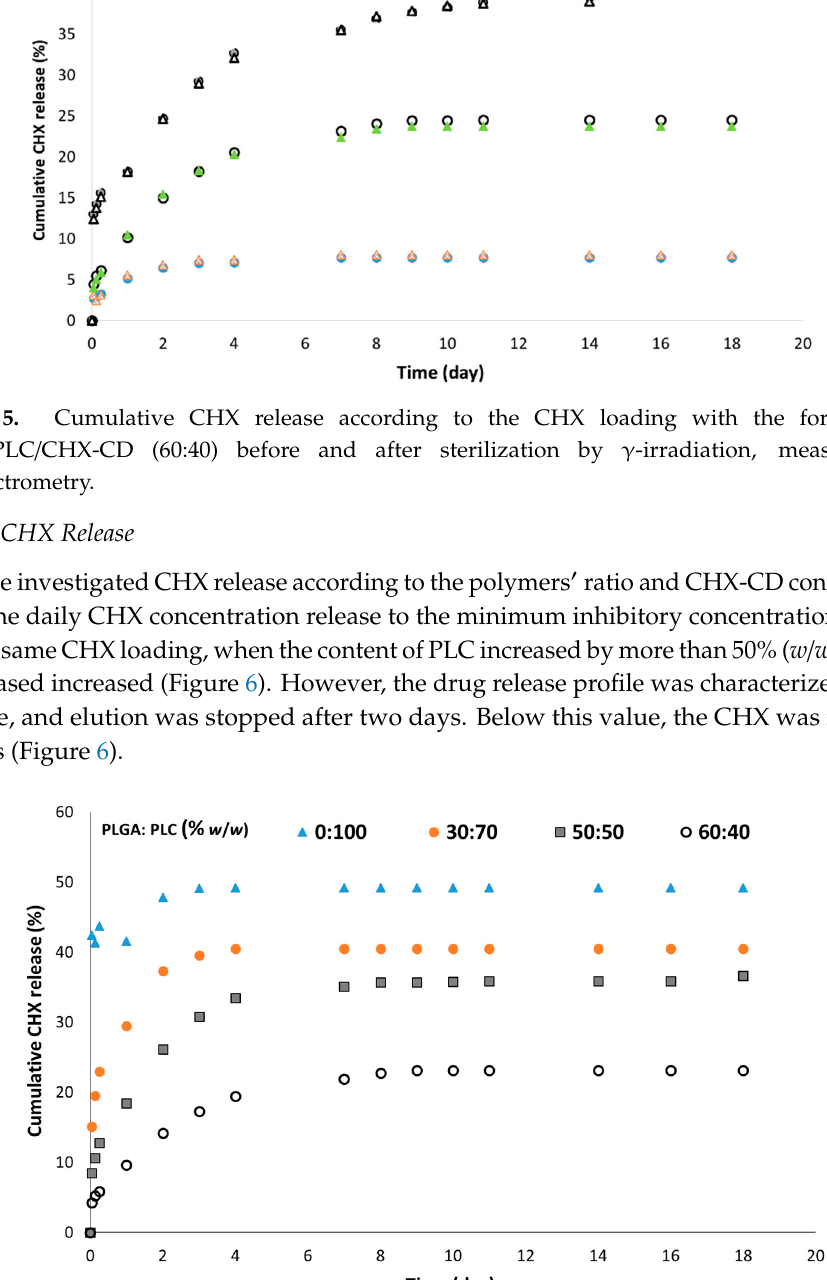
Figure 6. Cumulative CHX release according to the PLGA/PLC ratio. CHX-CD loading was 4%, measured by UV spectrometry.